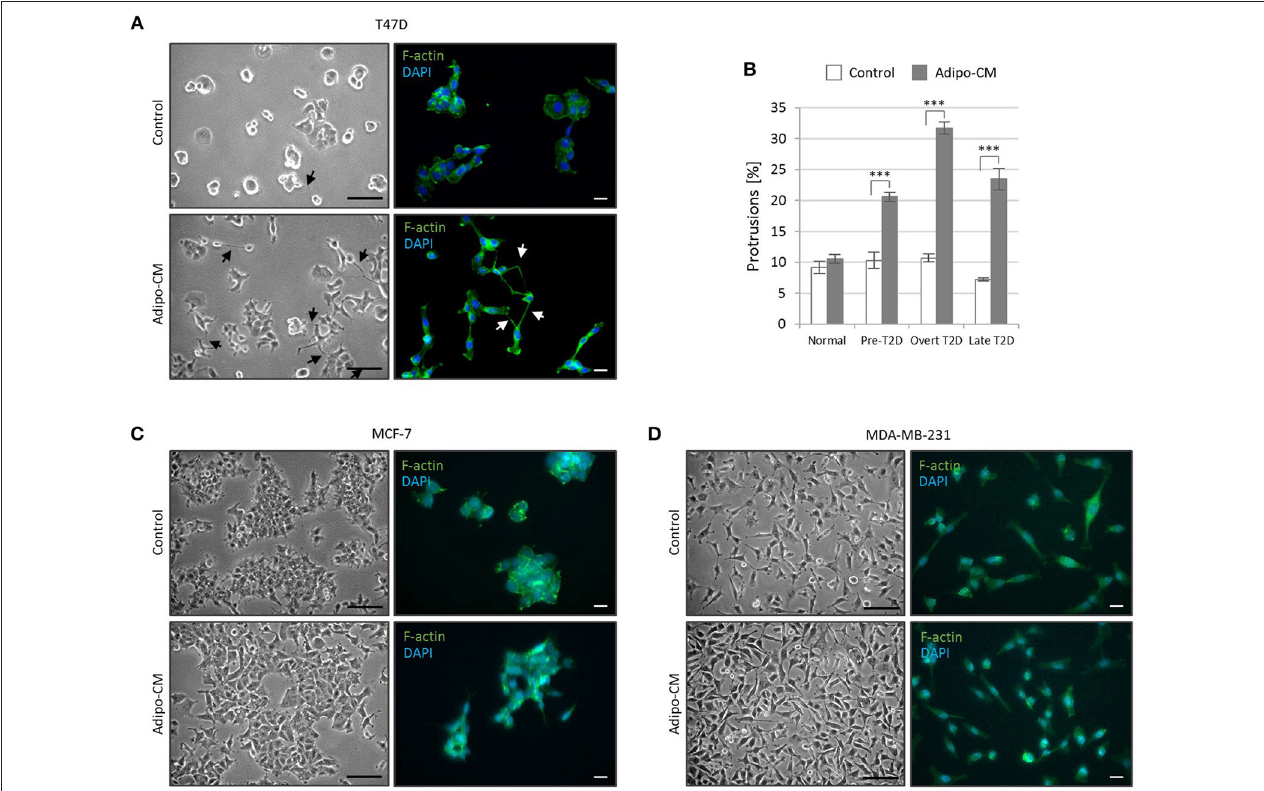
FIGURE 2 | Adipocyte-derived factors stimulate morphology alterations and protrusion extensions in T47D cells. The non-/low-invasive T47D cells were exposed to adipocyte conditioned media or control media under normal, pre-T2D, overt-T2D or late-T2D conditions for 48h. (A) Representative bright field images and immunofluorescence cytoskeletal F-actin staining depicting cell morphology of T47D cells in control or adipo-CM under overt T2D conditions. Arrows indicate cellular protusions. Scale bars: 50 and 20 µ m, respectively. (B) Graph shows quantification of percent cellular protrusions relative to total T47D cell numbers after exposure to adipocyte-derived factors (gray bars) or control (white bars). Data is presented as mean ± SE from nine random microscopic fields from one representative of three independent experiments. A minimum of 1,000 cells were quantified per condition and experiment. P -values based on two-way ANOVA with Bonferroni correction displaying significant differences between cells exposed to adipo-CM and control. *** P < 0.001. (C,D) Images showing cell morphology and F-actin staining of MCF-7 and MDA-MB-231 cells in control or adipo-CM under overt T2D conditions. Scale bar 50 and 20 µ m, respectively.